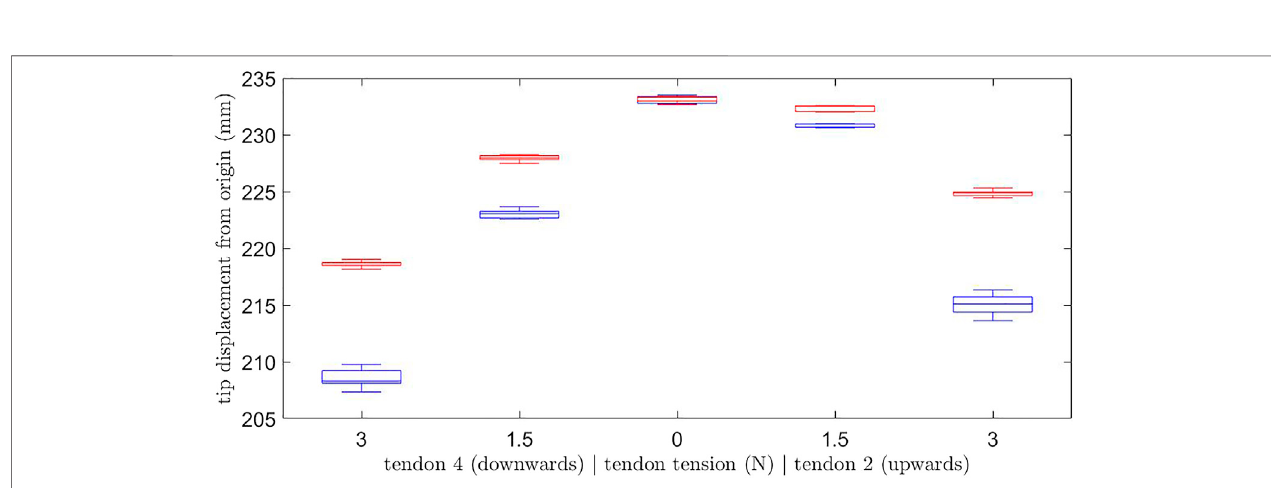
FIGURE7| Tipdisplacementfromtheglobaloriginfortensionsof0,1.5or3 Nintendontwoor4(onlyonetendon istensionedatatime)intheverticalplanewhen the desired value is achieved by increasing the tension from 0 N (red) or decreasing from 5 N (blue).